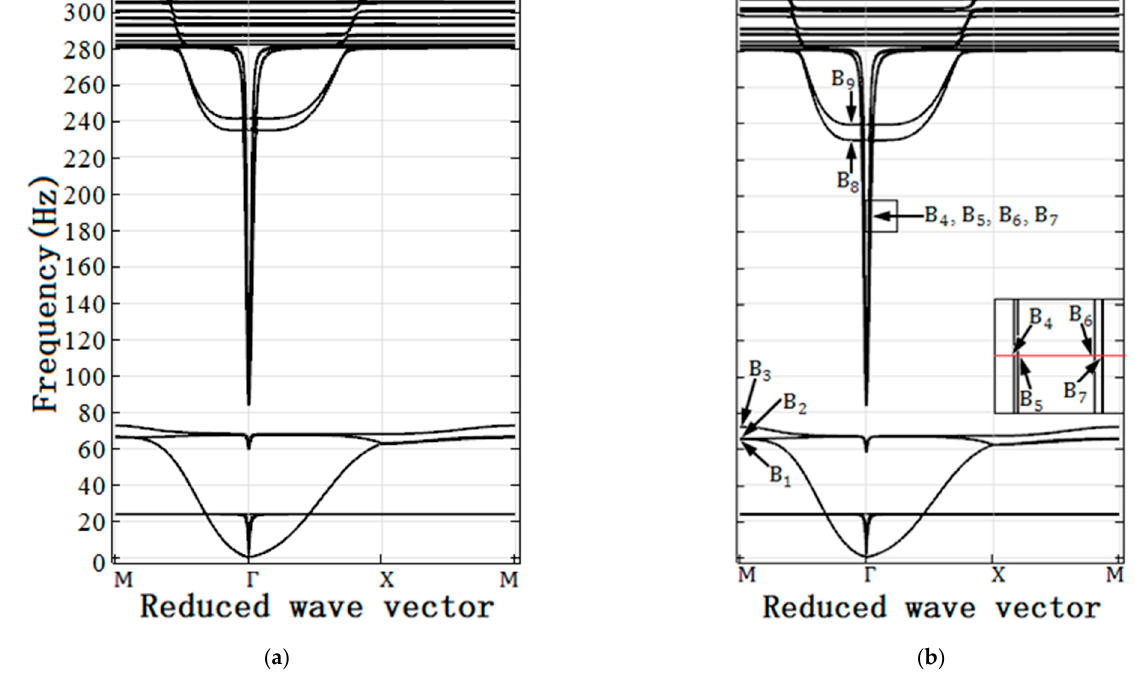
Figure 2. Band structures of stubbed ‐ on LRPC DPSs ( a ) with and ( b ) without surrounded soft shell. istic equation of FEM, it